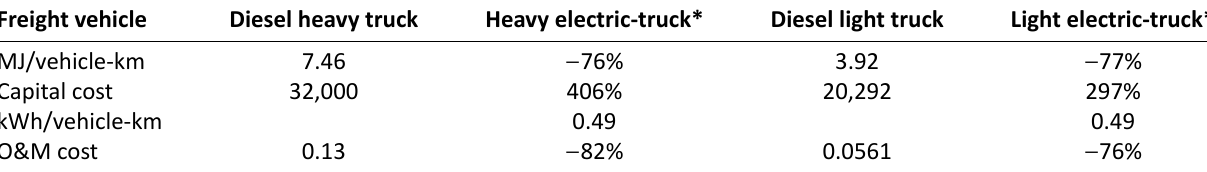
Table A9. Freight transport technology, based on DoE (2010) and ETSAP (2010).